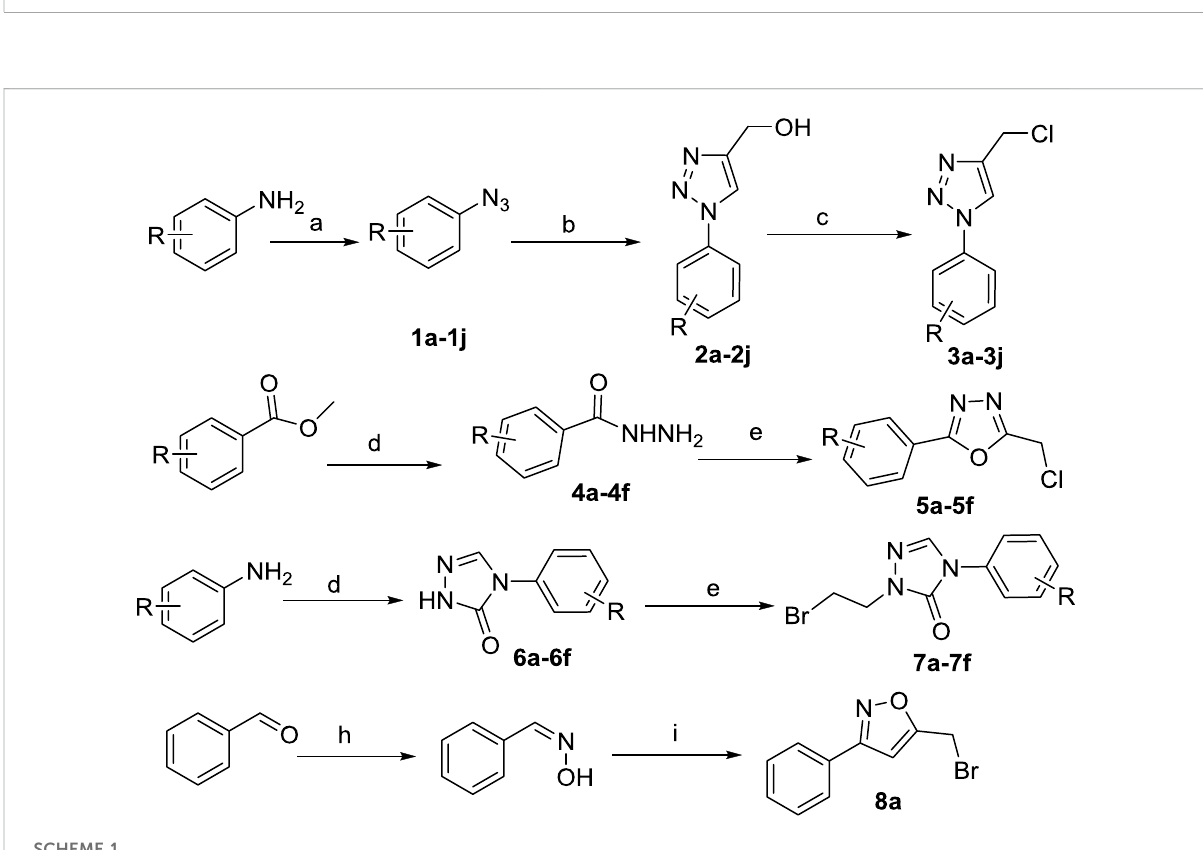
(cid:129) 5H 2 O,H 2 O, (cid:129) H 2 O, EtOH, re fl ux, overnight; (E) chloroacetic acid, POCl 3 ,